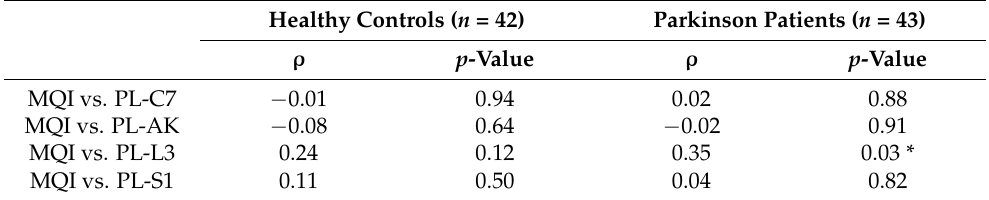
Table 3. Correlations of Muscle Quality Index and plumb lines in healthy controls and Parkinson’s disease